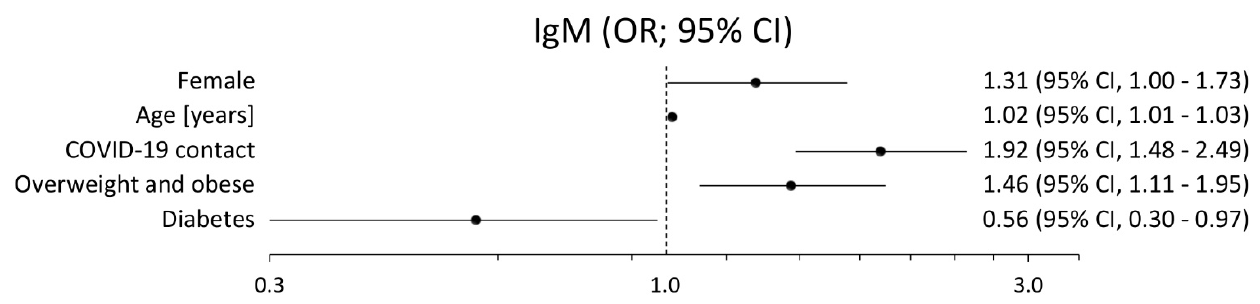
Figure 1. Results of the multivariable analysis (adjusted odds ratio and its 95% confidence interval) for the relationship between the positive results of the IgG test and particular classification variables.